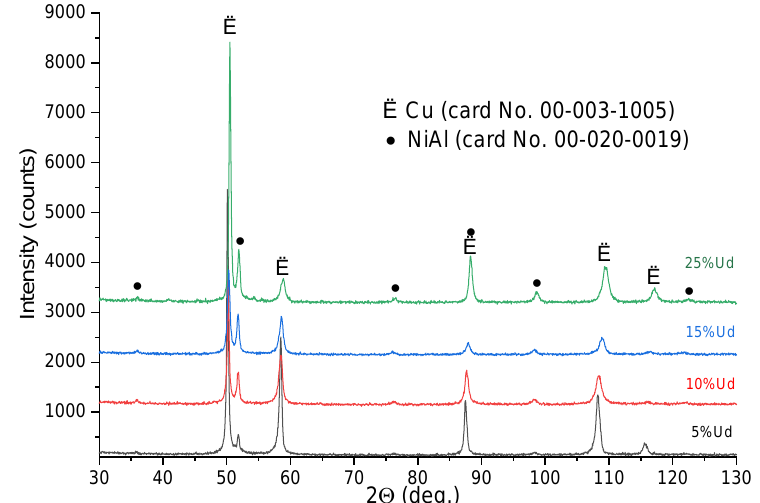
Figure 4. X-ray diffractograms of the bronze/Udimet-500 composites.